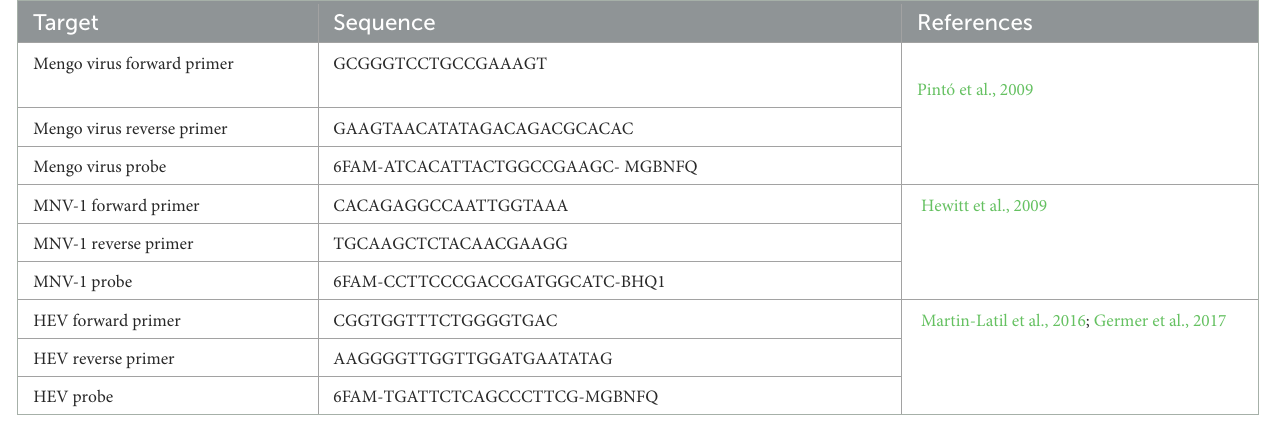
TABLE 2 Detection of HEV in pork liver pâtés collected from grocery stores and in raw livers produced in the province of Quebec. Food matrix Total no. of